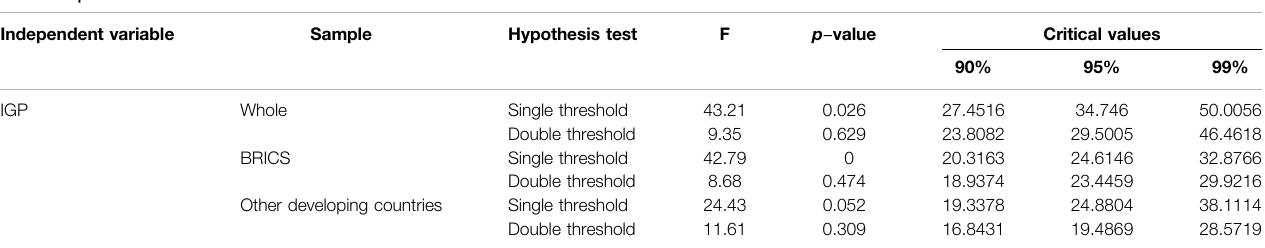
TABLE 5 | Test for the existence of threshold.